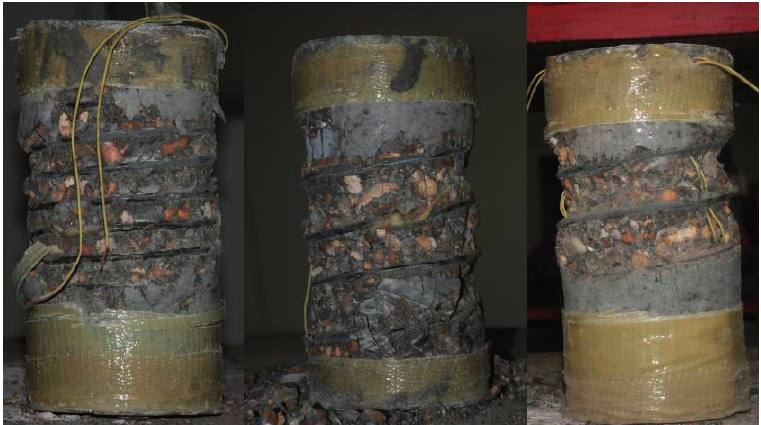
Figure 6. Typical failure of